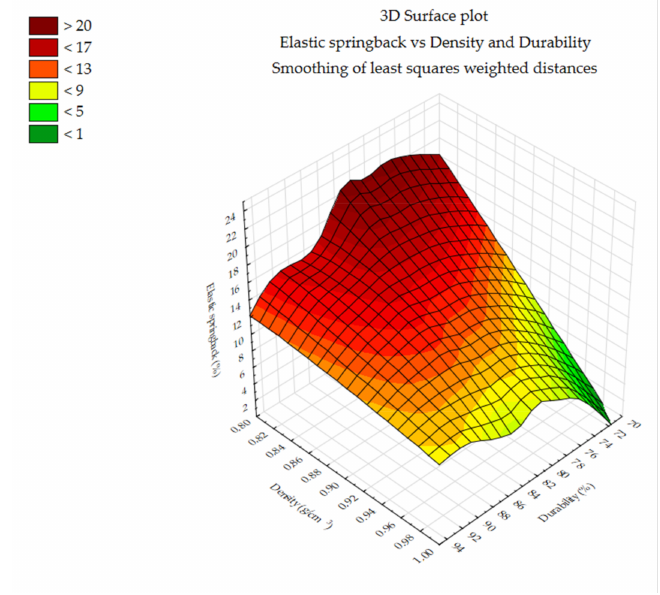
Figure 8. Elastic springback vs. density and durability—miscanthus.